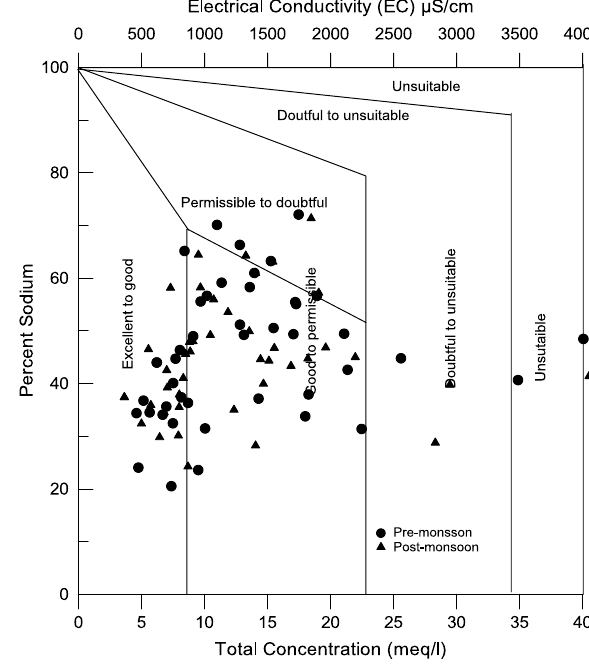
2 value during pre-monsoon. b Nine-year (2006–2013) temporal representation